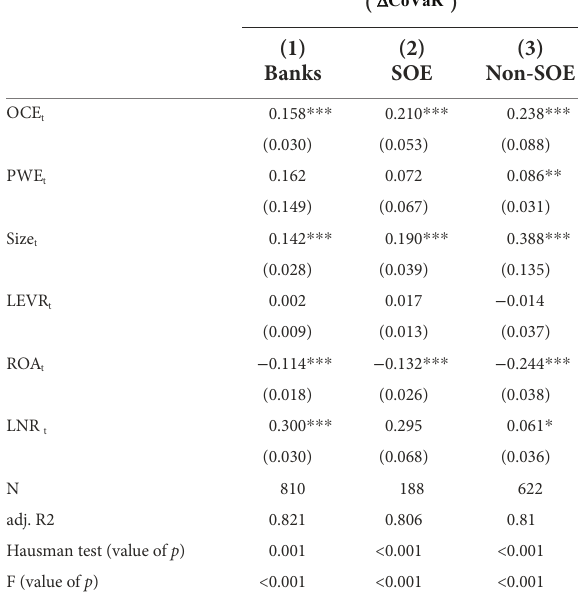
TABLE 2 Regression analysis for banks.